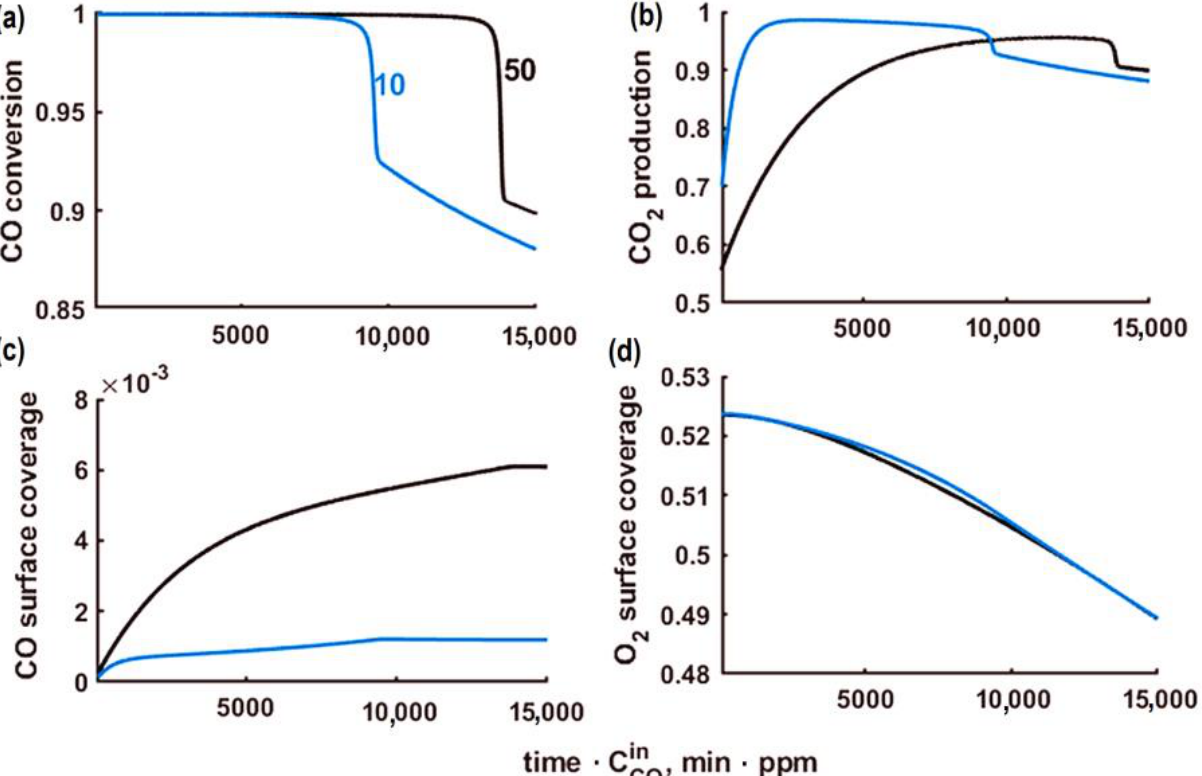
Figure A2. ( a ) Time dependencies of CO oxidation reaction rate for various initial CO concentrations and ( b ) logarithmic dependencies of the initial reaction rates and the steady state rates on the initial CO concentration at 25 °C.